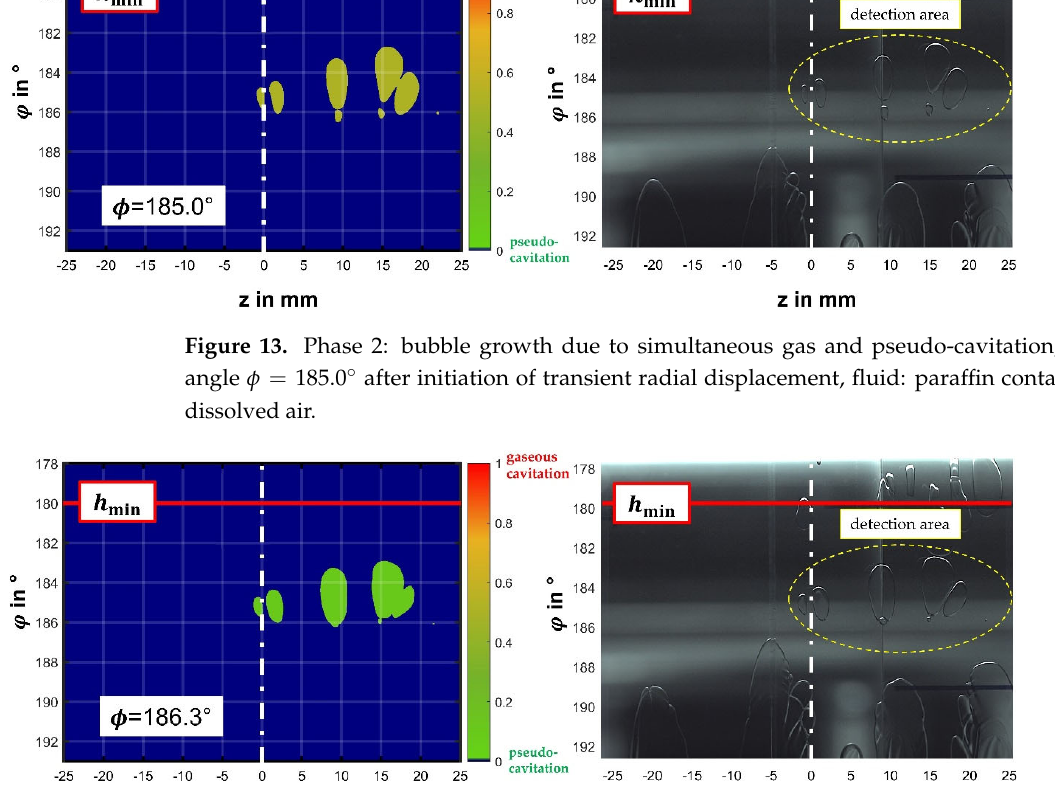
Figure 14. Phase 3: bubble growth by solely pseudo-cavitation, rotational angle φ = 186.3 ◦ after initiation of transient radial displacement, fluid: paraffin containing 100% dissolved air.